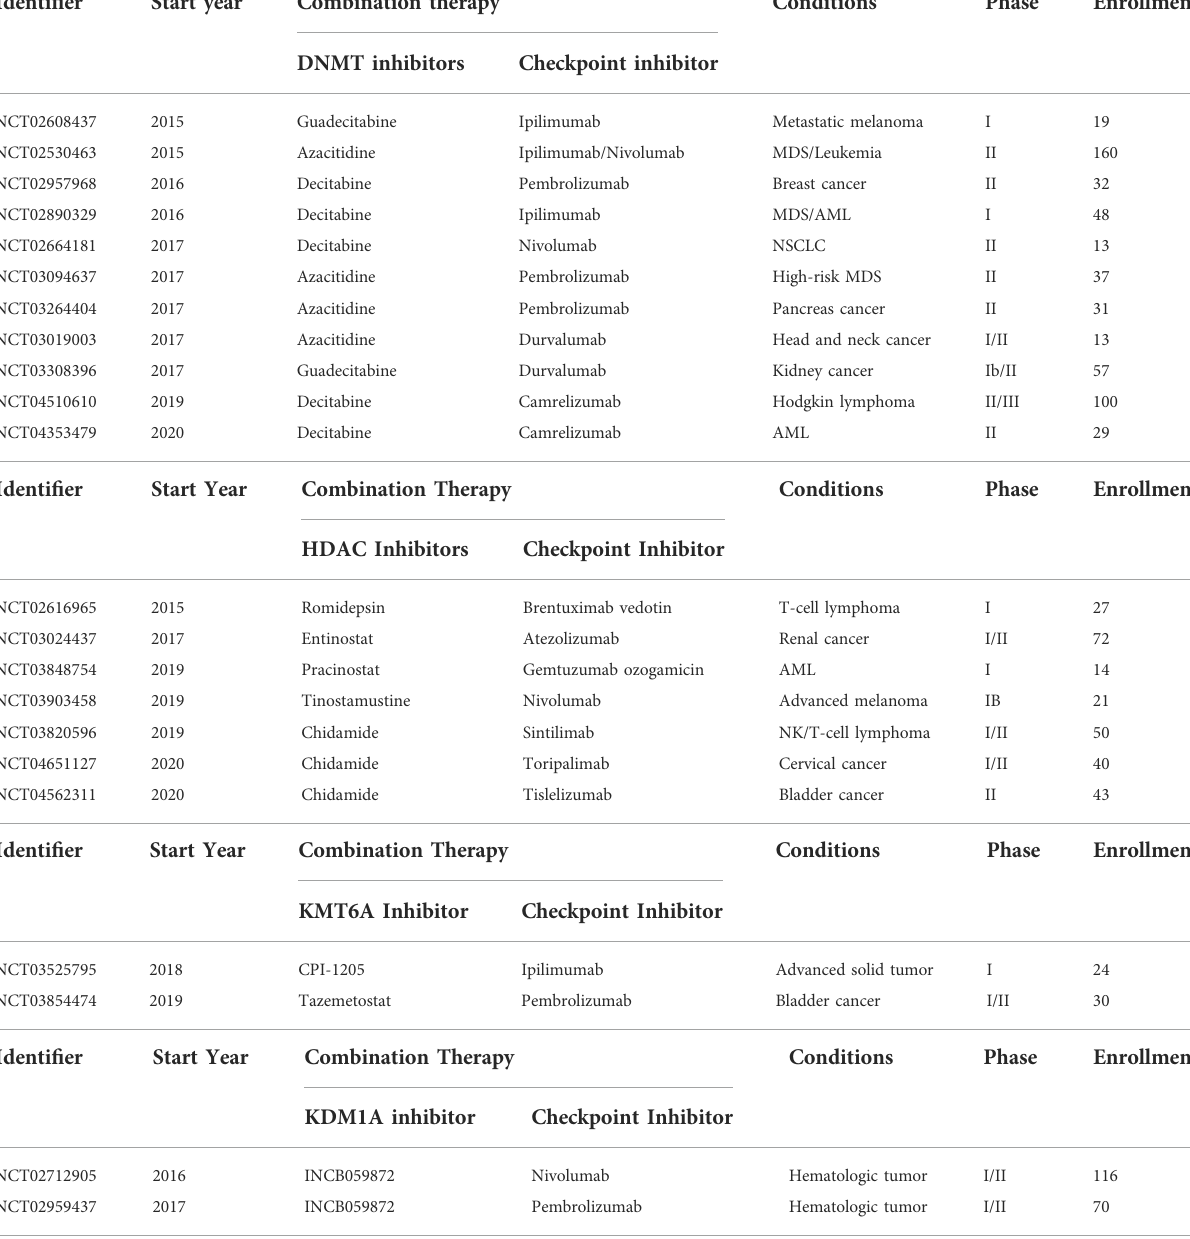
TABLE 7 Ongoing clinical trials of combined anti-epigenetic drugs and immune checkpoint